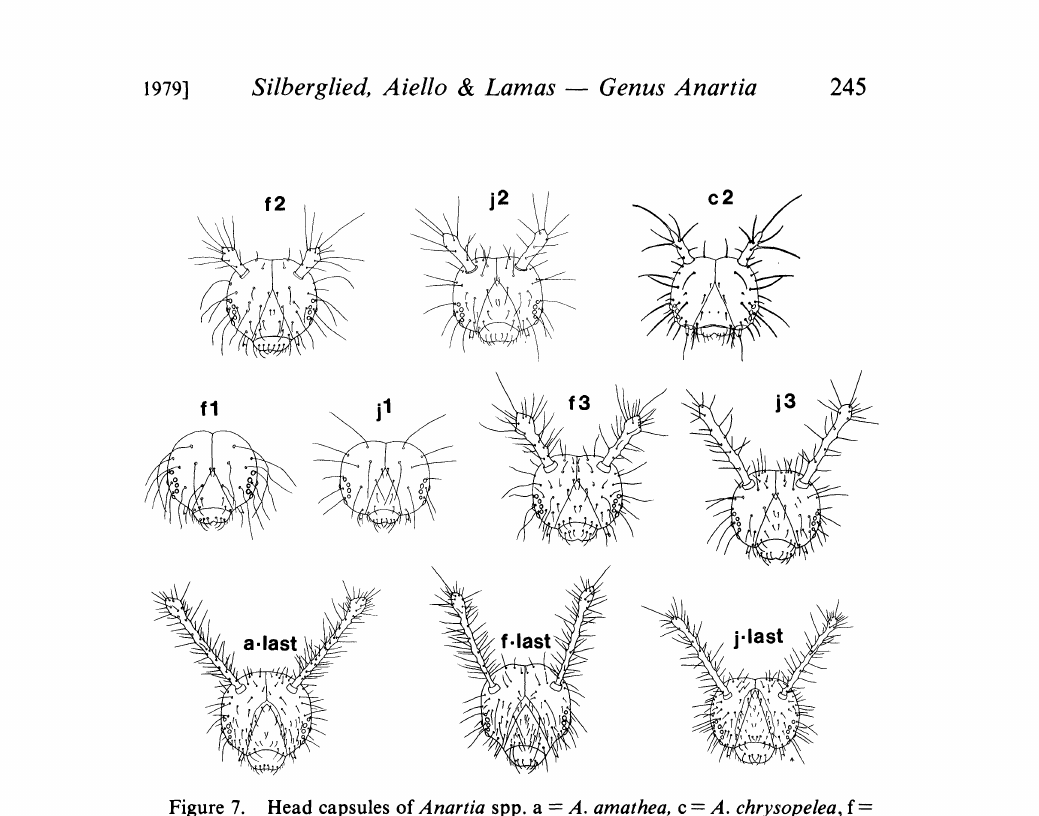
Figure 7. Head capsules of Anartia spp. a A. amathea, c A. chrysopelea, f A. fatima, A. jatrophae. Numbers on figure indicate instar number; numbers in brackets are head capsule widths in mm. f2 [width of head capsule 0.6 mm], j2 [0.5], c2 [0.575, measurement and figure from Dethier, 1941], fl [0.4], jl [0.4], f3 [1.0], j3 [0.9], a-final [2.5], f-final [3.0], j-final